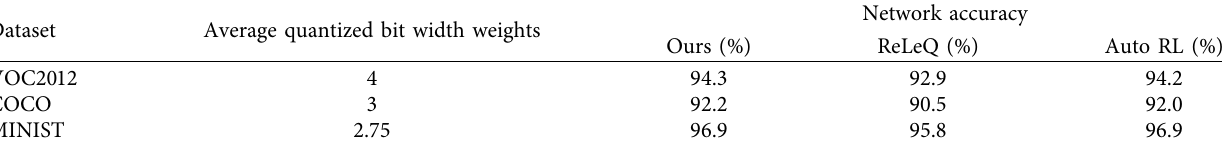
Table 7: Comparison of quantization for different